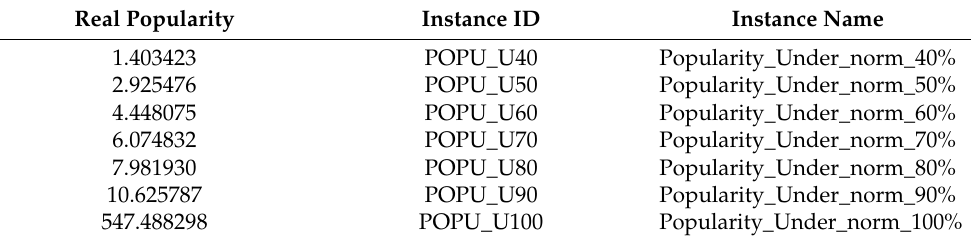
Table A2. Categorization criteria of “Popularity” class in the experiment.